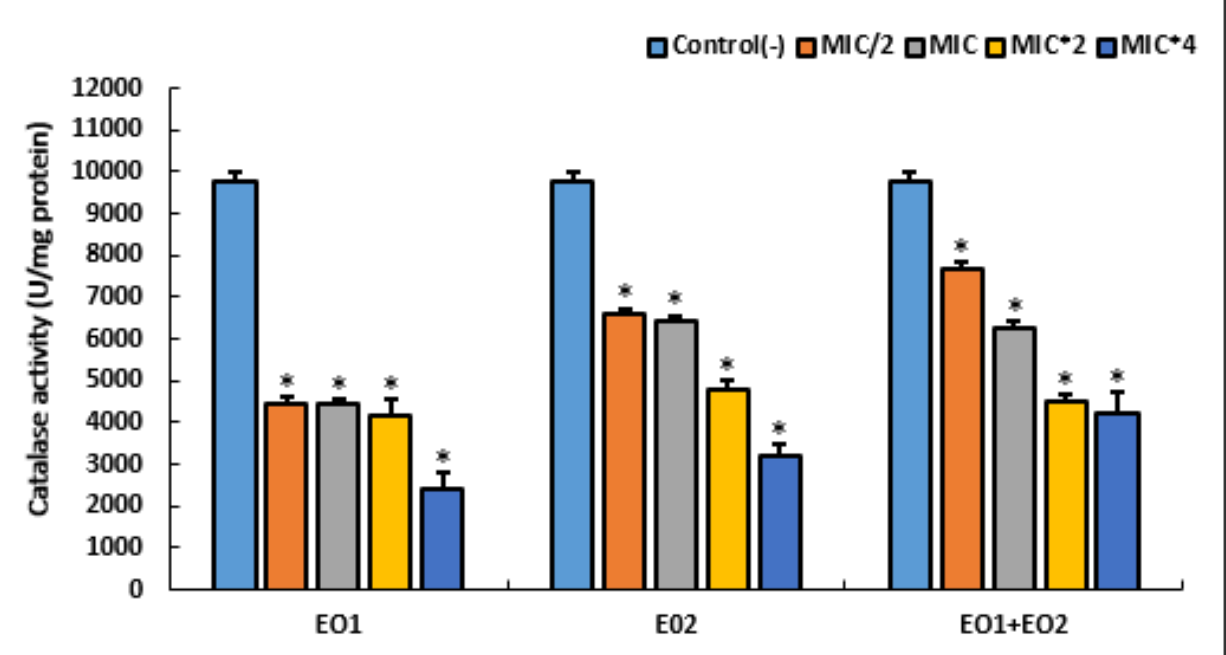
Figure 3. Effect of different concentrations of R . officinalis (EO1) and M. communis (EO2) essential oils and their combination (EO1 + EO2) on the activity of oxidative stress enzyme (catalase) in S. aureus ATCC 25923. Bacteria were incubated with various concentrations of EOs for 24 h. An asterisk represents a significant difference ( p < 0.05) between each treatment and the negative control .